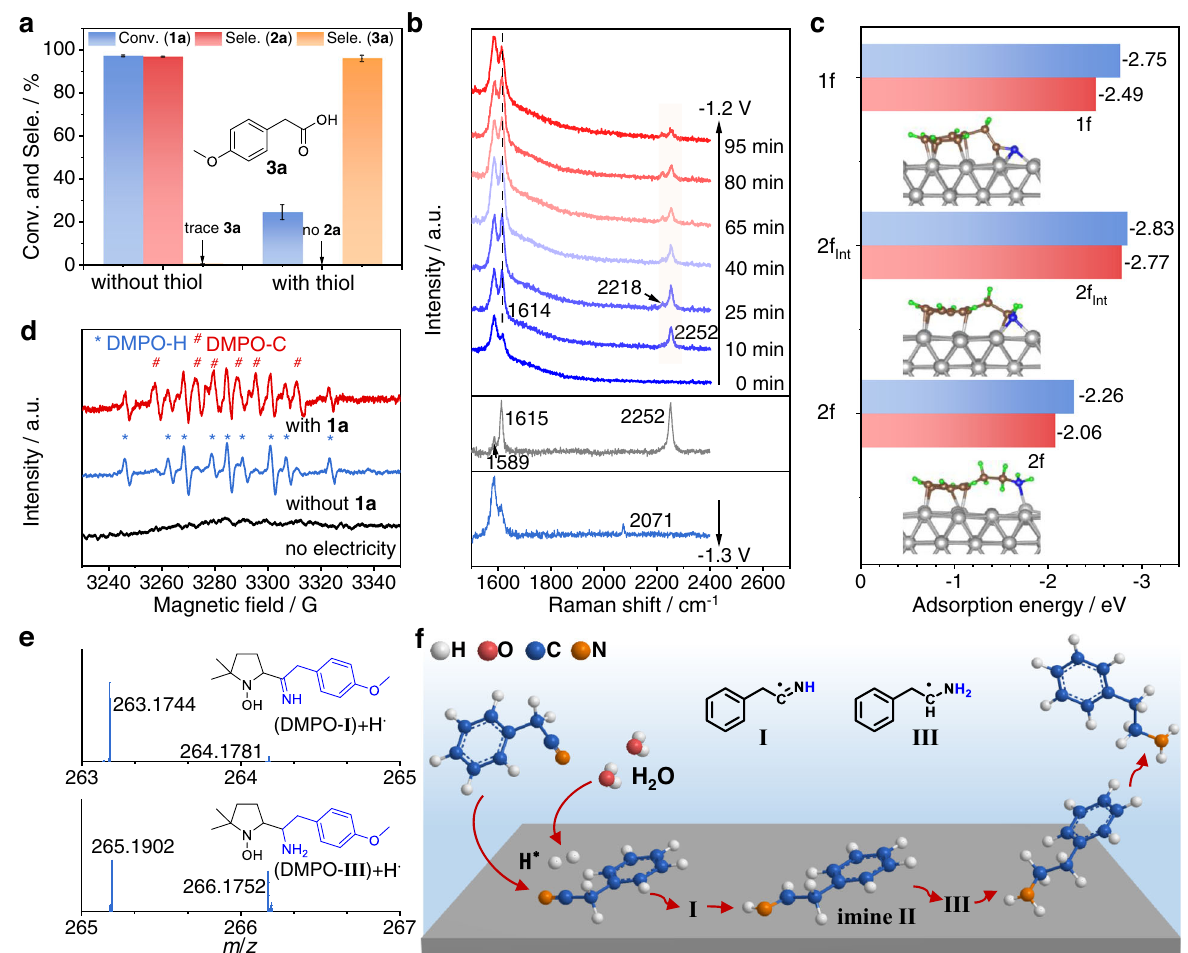
Fig. 4 | Combined control experiments with theoretical calculations for (blue)andLC-Fe(red),respectively(insert:thestableadsorptionmodesof 1f , 2f Int , mechanistic studies. a Compared results of electrocatalytic hydrogenation of 1a and 2f ). d Electron paramagnetic resonance trapping for hydrogen (*) and carbon overLC-Feand1-dodecanethiol(2×10 − 3 mmol)modi fi edLC-Fe,respectively,under (#)radicalsoverLC-Fe. e HR-MSanalysisofthespin-trappingexperimentofcarbon standard conditions. b In situ Raman tests in a mixed 1.0M KOH/dioxane (3:1v/v, radicalsduring 1a electroreductionwithH 2 ObyusingDMPOasatrappingagent. f A 8mL) solution for electrocatalytic hydrogenation of 1a (0.1mmol) over LC-Fe at proposed reaction − 1.2 and − 1.3V, respectively. c Comparisons of E ads of 1f , 2f Int , and 2f on Fe foil